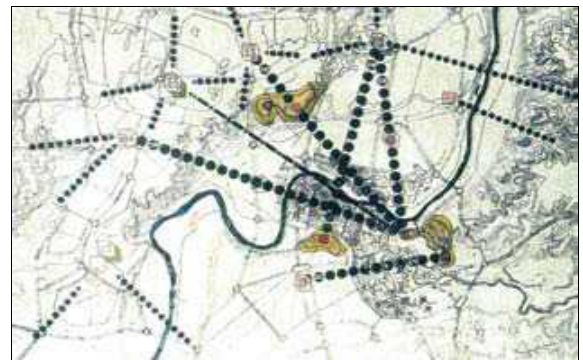
Fig. 6. Proposals of Vilnius silhouette and skyscraper system. Architect A. nasvytis, 1974